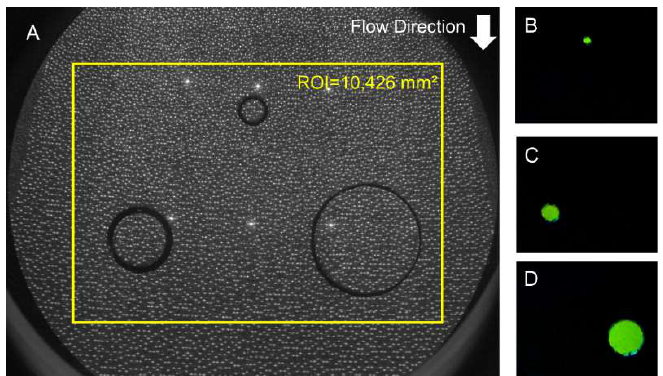
Figure 2. Image of the CMOS-camera showing the round panel of the calibration setup with three different test areas ( A ). Exemplary visualization of the DOF algorithm for each test area, the color represents the drop of the test areas ( B – D ).